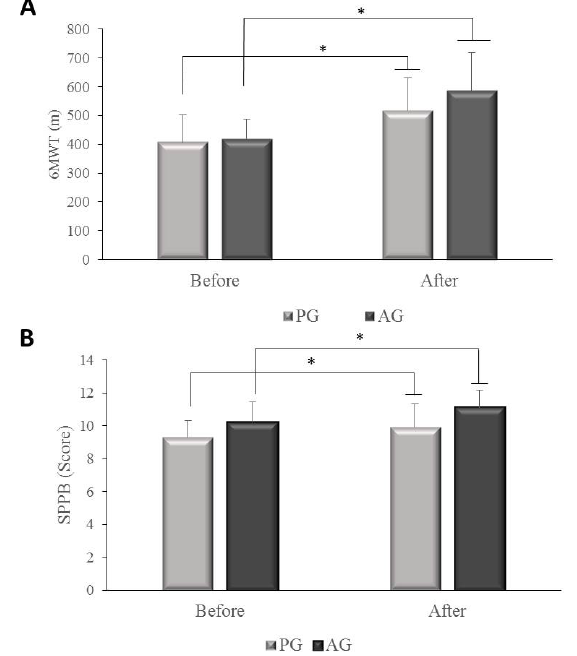
(m). B) Values as means and standard deviations of SPPB.